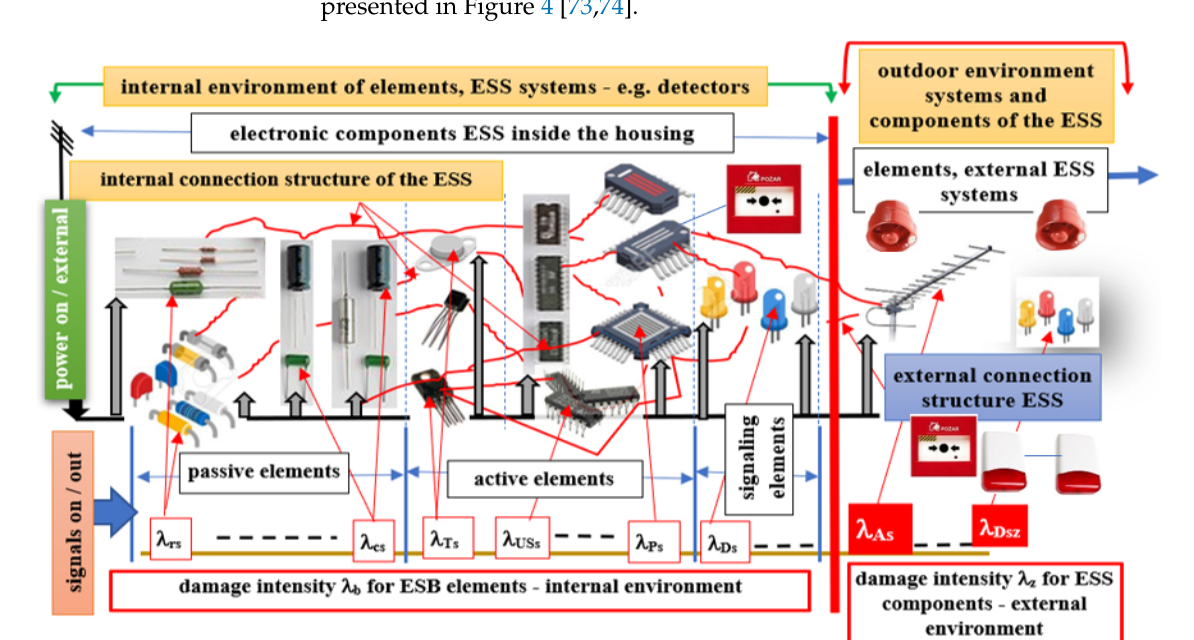
Figure 5. Adverse impact of an external and internal environment on the operation process of individual FAS elements, devices or modules.